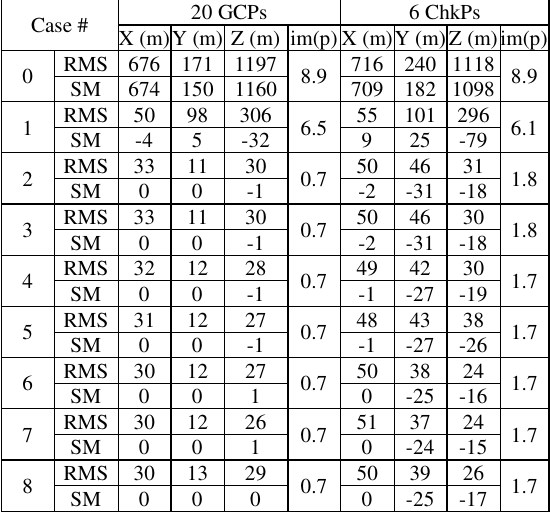
Table 1. GLAS Errors at Ground Control and Check Points (GCPs and ChkPs, resp.)